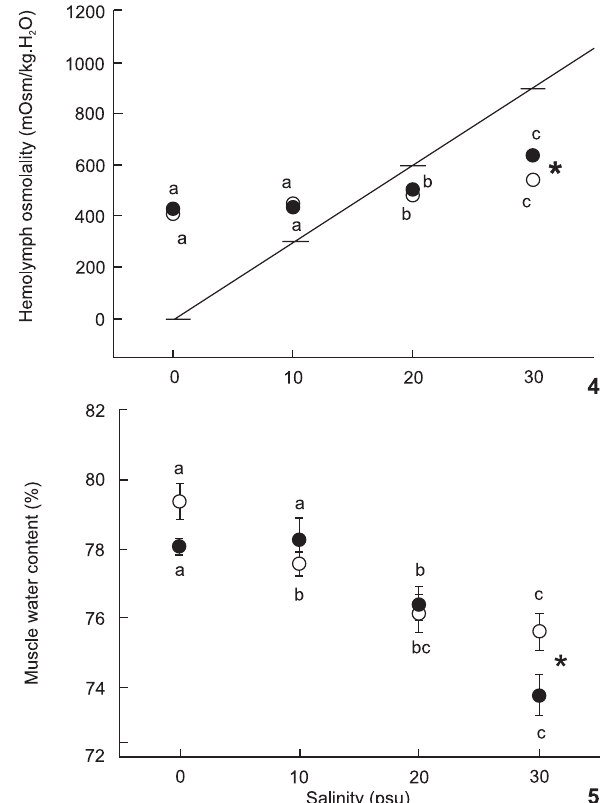
Figures 4–5. Hemolymph osmolality (4) and muscle water content (5) of M. acanthurus exposed to salinities 0 (control), 10, 20, and 30 psu for 4 (white circles) and 8 hours (black circles). Dashed line represents water expected values, from the relationship 1 psu = 30 mOsm/kg H O, short horizontal lines indicate value of calculated 2 water osmolality for the tested salinities. Different letters mean dif- ferences between salinities within each time of exposure. * = value for 4 hours is different from value for 8 hours within a same salinity.